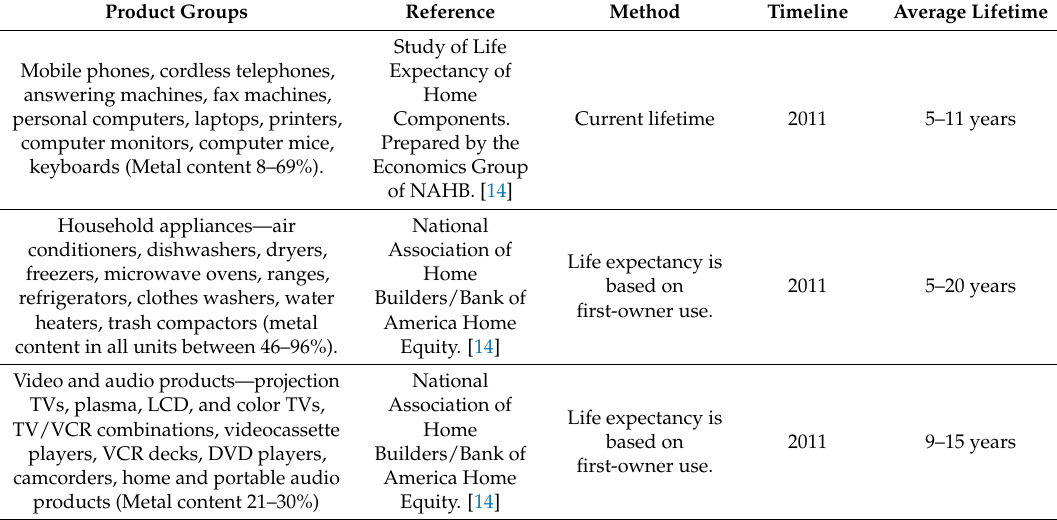
Table A4. Average in-use lifetime of appliances in the United